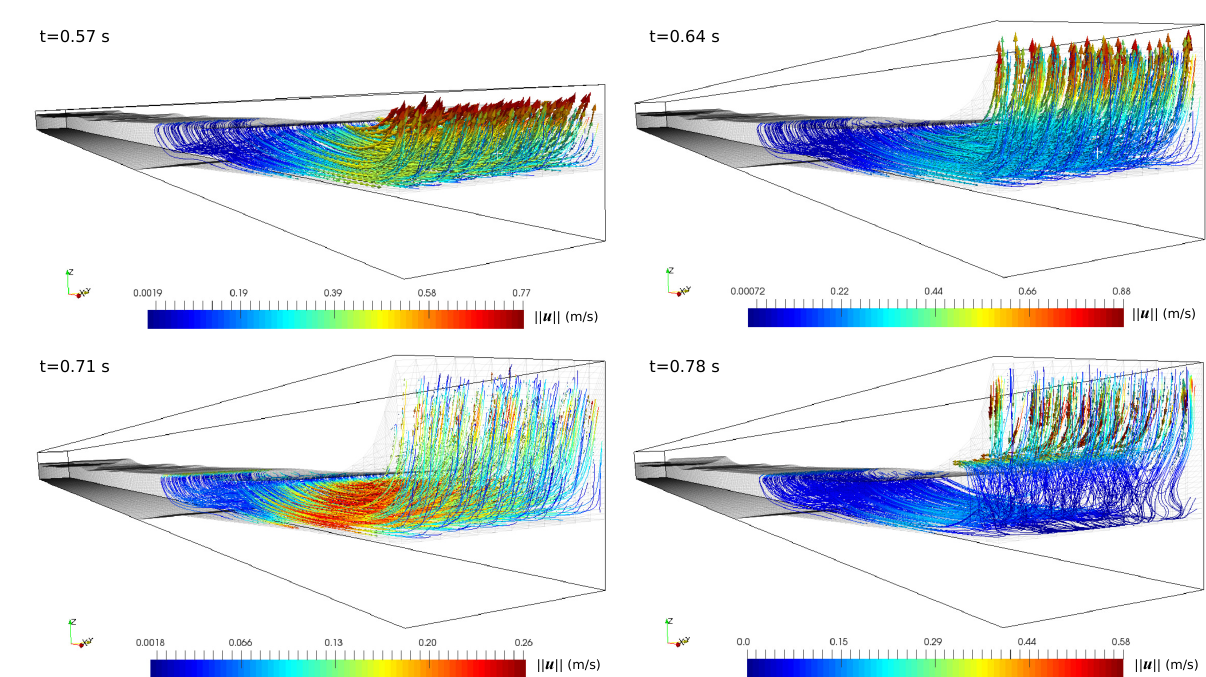
Figure 6. Instantaneous velocity field and magnitude of the simulated wave during its impact on a vertical seawall for Test B.